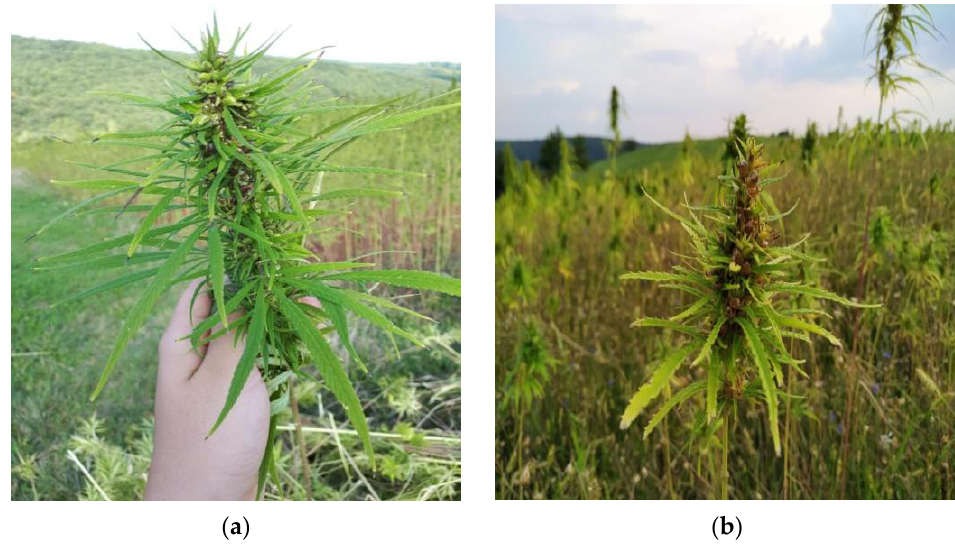
Figure 1. Investigated hemp plants ( a ) harvest 2018; ( b ) harvest 2019.